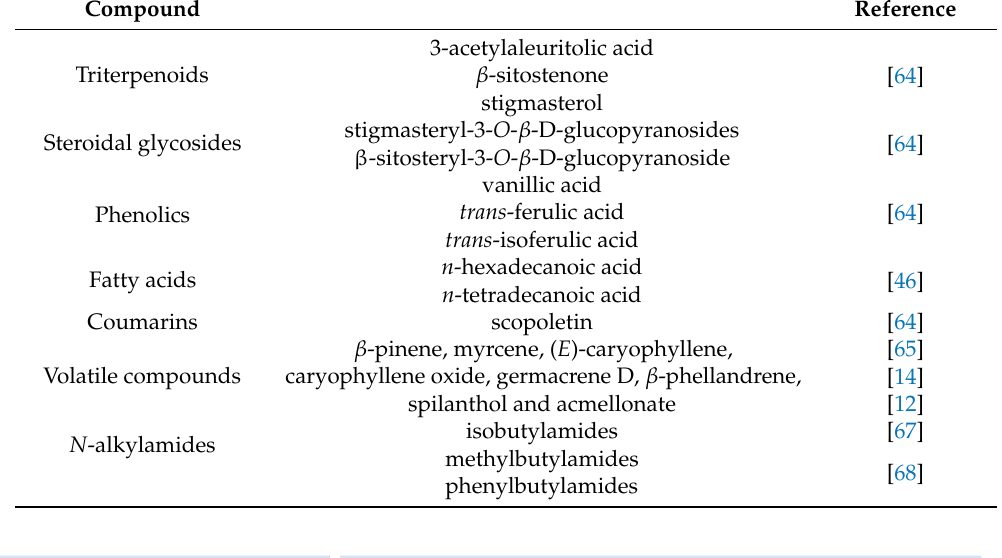
Table 2. Secondary metabolites detected in Acmella oleracea .